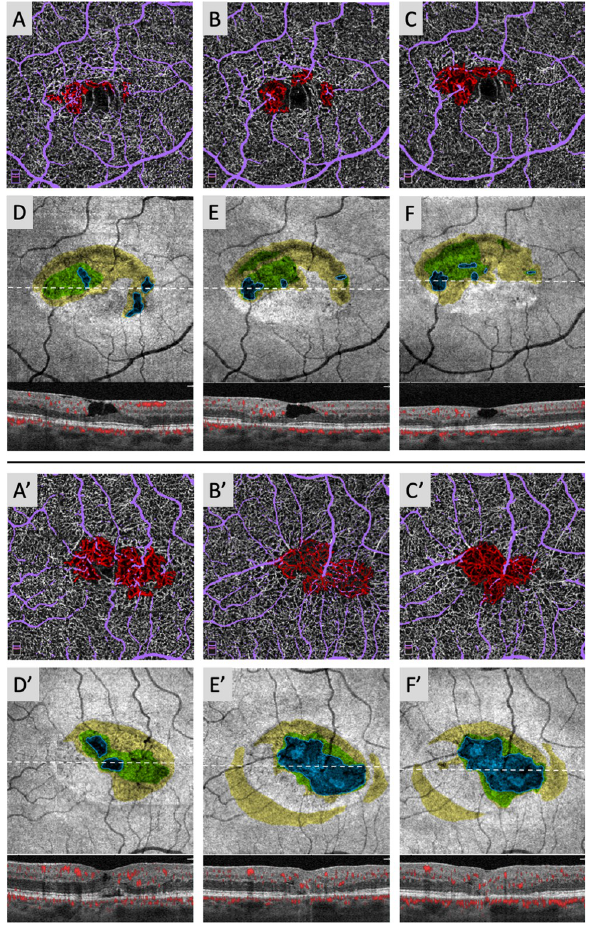
Fig 4. Areas of IZ loss qualitatively predict future EZ loss in long-term follow-up. Right eye (A–F) and left eye (A’– F’) of 56-year old male with nonproliferative (Right eye: OCT Stage 2; left eye: OCT Stage 3) MacTel at initial imaging (left column). OCTA imaging of DCP telangiectasia (red) and large superficial vessel overlay (lavender) shows dynamic changes in telangiectasia boundaries in both eyes (A–C and A’–C’), with substantial superficial vessel structural change in the left eye at 2.5 years (B’). Areas of IZ attenuation (yellow), IZ loss (green), and EZ loss (blue; outlined for clarity) on the OCT slab show dynamic changes in the right eye (D–F), while the left eye (D’–F’) shows overall coalescence and enlargement of EZ loss, expanding within and ultimately replacing areas of IZ loss.